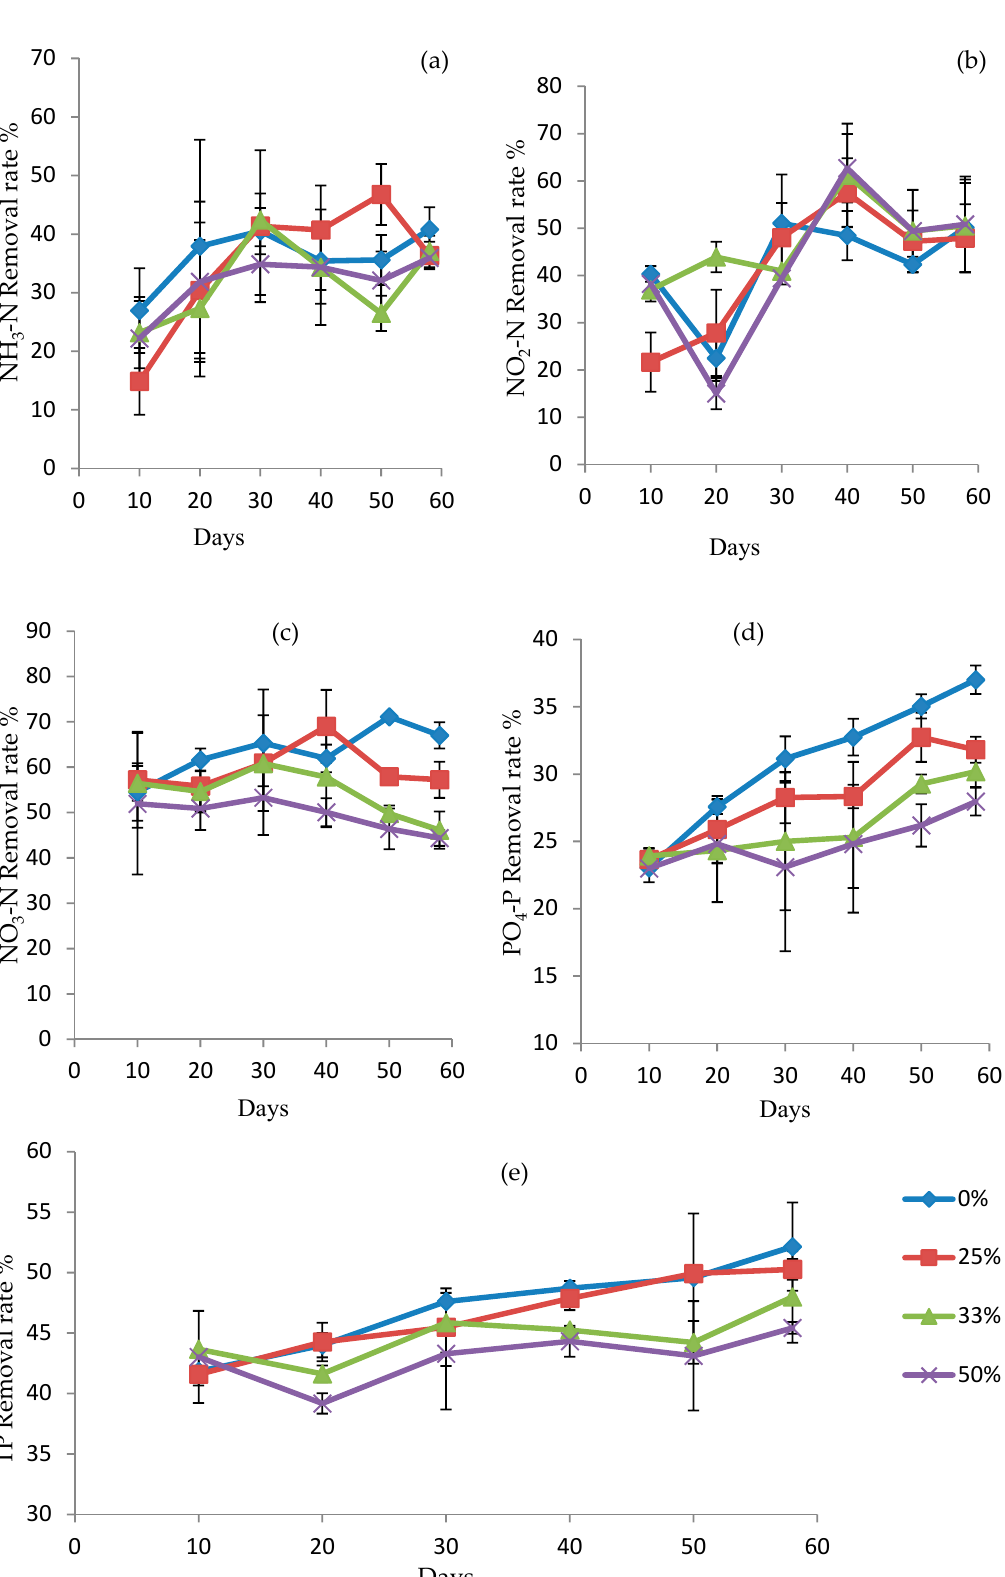
Values (means ± SE) in the same row having different superscript letters (a, b, c….) are significantly different (Duncan test; P <0.05); data are the means of three replicates (n = 3).